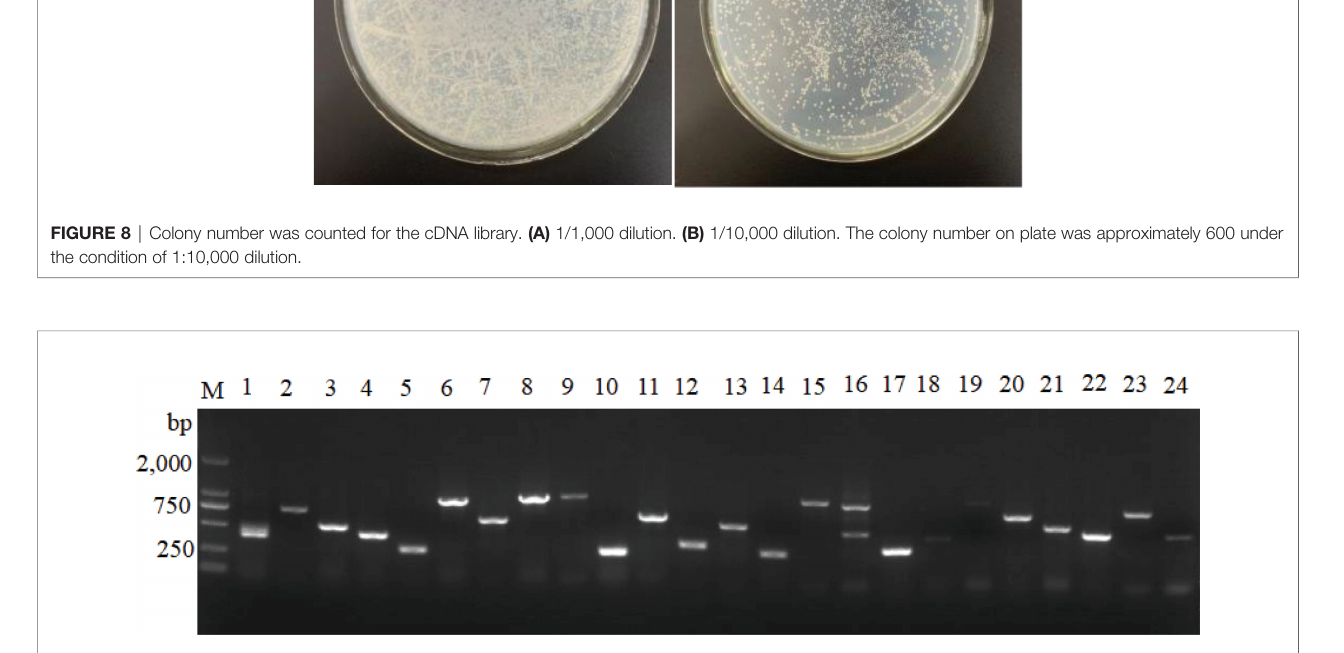
FIGURE 9 | Identi fi cation of the integrity of the recombinant sequence of the cDNA library. M: DL 2000 Marker. 1 – 24: PCR veri fi cation of positive colonies. Positive colonies were selected to evaluate recombination ef fi ciency by PCR ampli fi cation with primers T7 and 3 ’